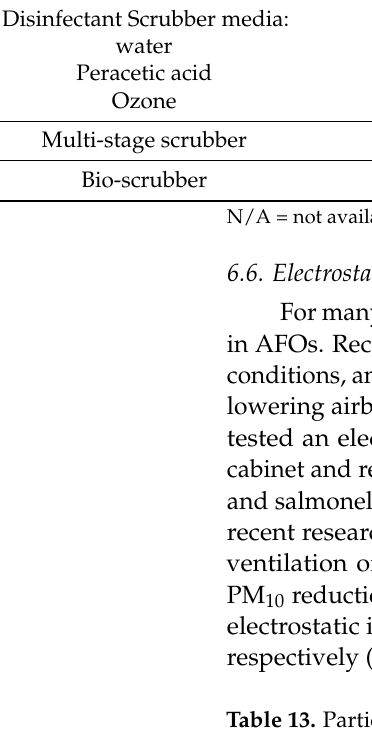
Table 13. Particulate matter and airborne bacteria reduction with electrostatic